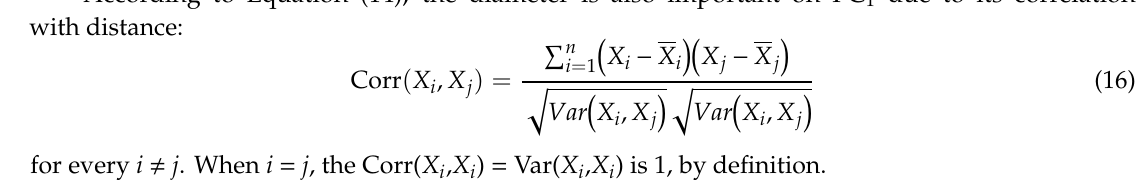
Figure 8. Biplot of principal component 1 (related to distance d(c,c) parameter) versus principal component 2 (factor f ), considering the correlation mode [13].